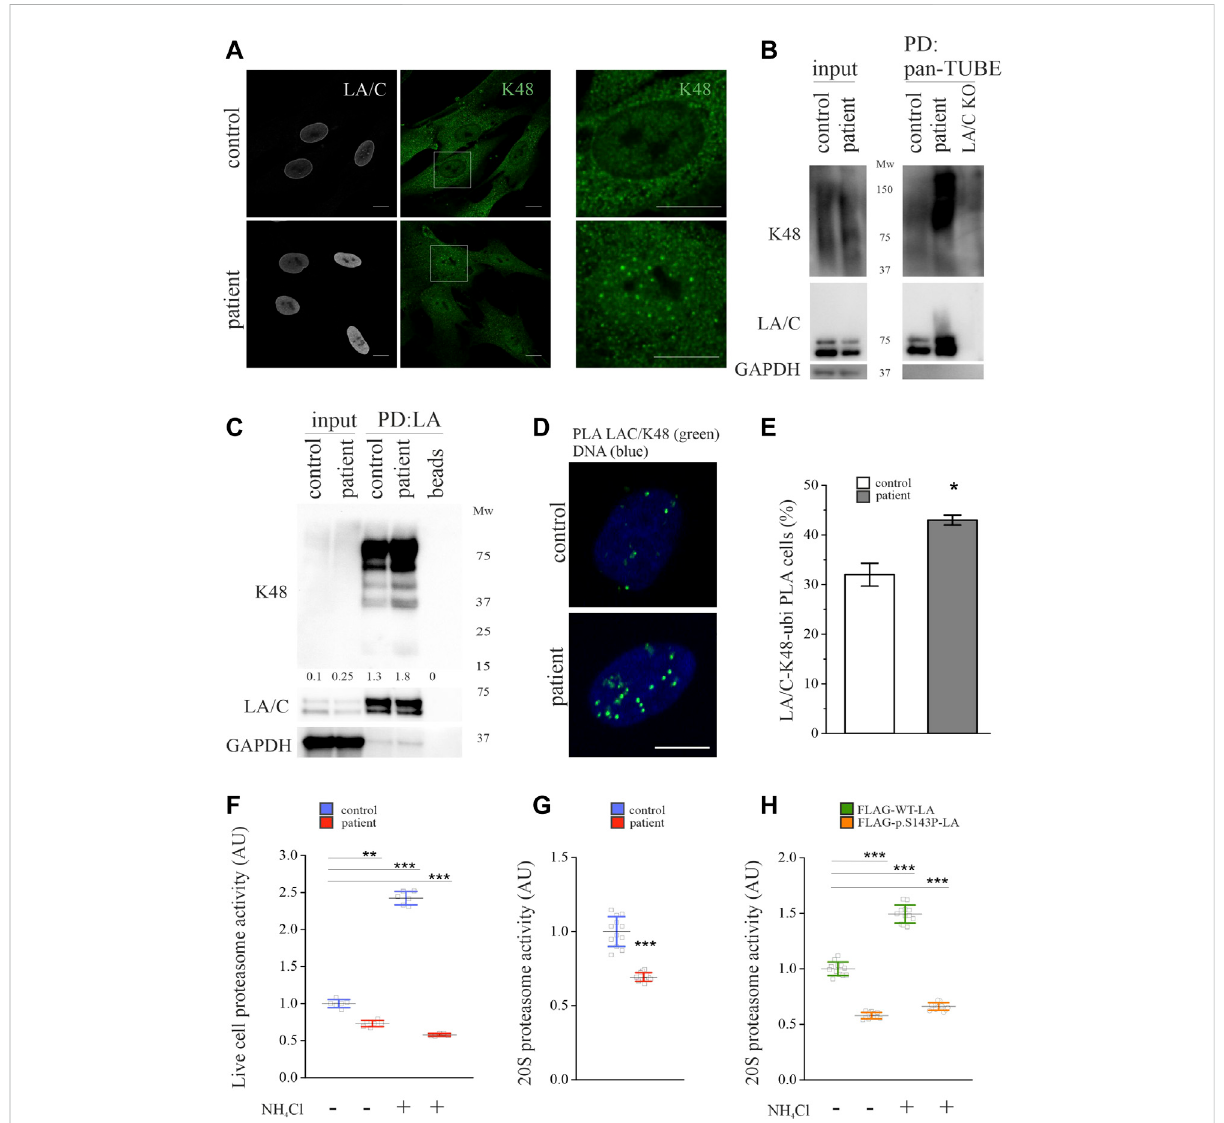
FIGURE 2 LaminsAandCareubiquitinatedbyK48-linkedchainsin LMNA mutantpatient fi broblasts. (A) Representativeconfocalmicroscopyimagesfrom control and patient fi broblasts stained for lamins A and C and K48-linked ubiquitin chains. Scale bar 10 µm. (B) Pulldown with GST-tagged recombinant pan-tandem ubiquitin-binding entity (pan-TUBE) under denatured conditions. (C) Pulldown with lamin A antibody under denatured conditions. K48-ubiquitinlevels werenormalized to GAPDH, which was used as a loading control. (D-E) Proximity ligation assay (PLA) of lamins A and Cand K48-ubiquitinin thecontrol and patient fi broblasts as calculated from > 300individualcells. Cellswith more than three PLA signals were considered positive. Data are expressed as mean ± s.e.m, * p < 0.05. (F) Proteasome activity of control and patient fi broblasts treated with or without 20 mMNH 4 Clfor24 h.N=3individual experiments. (G) Chymotrypsin-likeactivityof20Sproteasomesisolatedfromcontrolandpatient fi broblasts (N=3). (H) Chymotrypsin-likeactivityof20S proteasomesisolatedfromHelacellsexpressingeitherFLAG-tagged WT-LAorp.S143P-LAandtreated with or without 20 mM NH 4 Cl for 24 h (N = 3). The whiskers show mean values ±s.d ** p < 0.01, *** p <